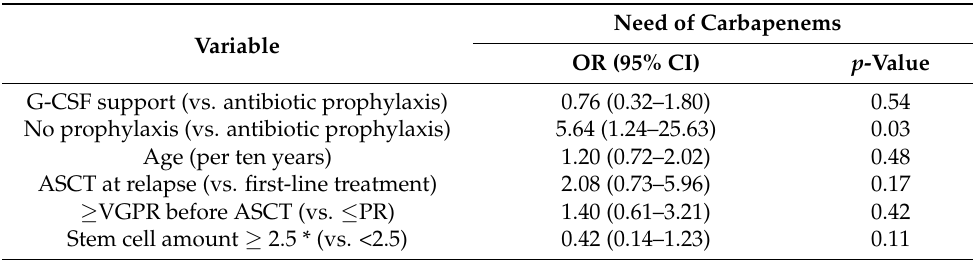
Table 4. Multivariable mixed effects model on the impact of the anti-infective strategy on the need of carbapenems.